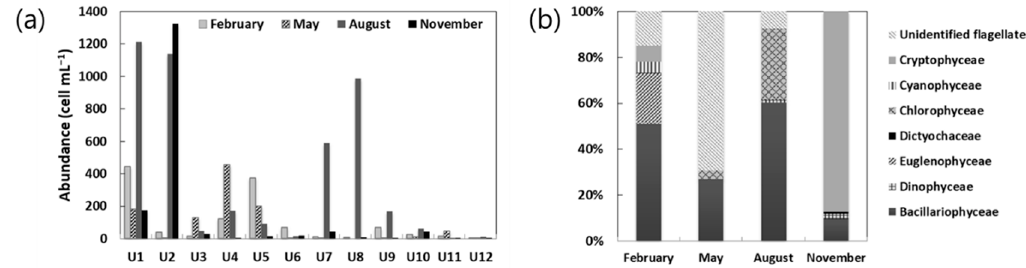
Figure 8. Spatiotemporal phytoplankton abundance ( a ) and seasonal composition of the phytoplankton community ( b ) in the Taehwa River estuary in Korea.